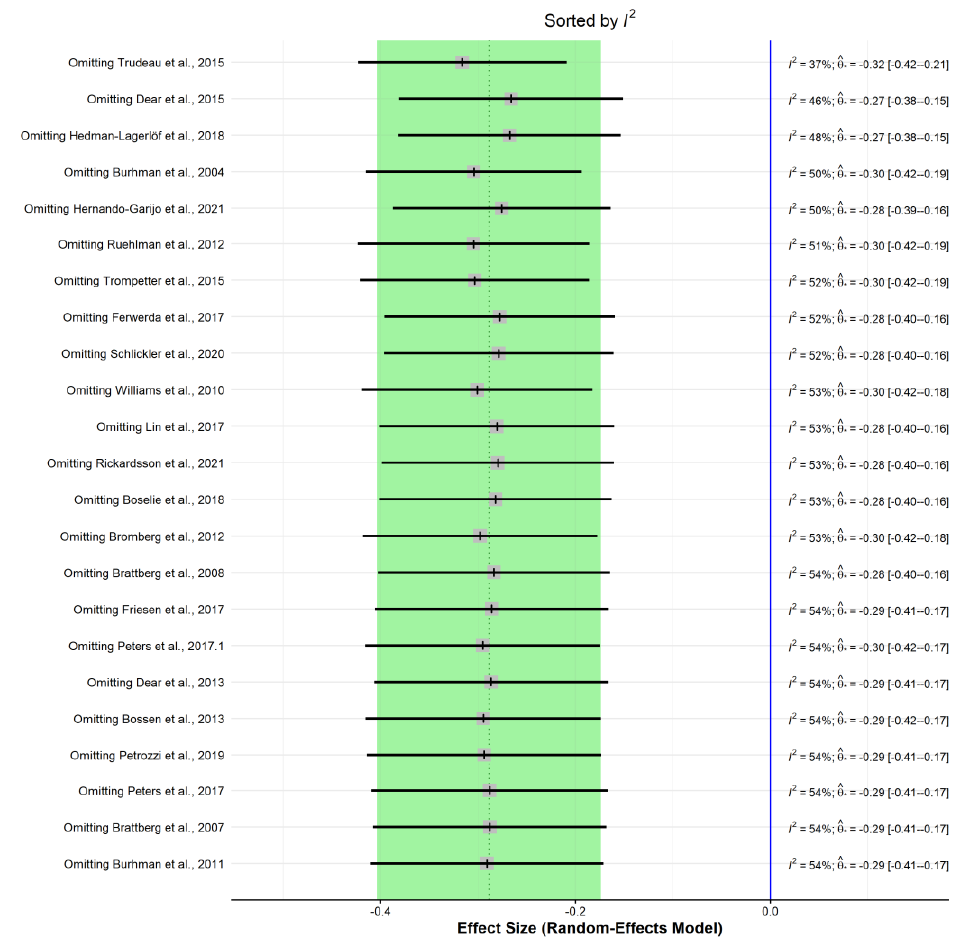
Figure A13. Leave-one-out figure of all the studies.